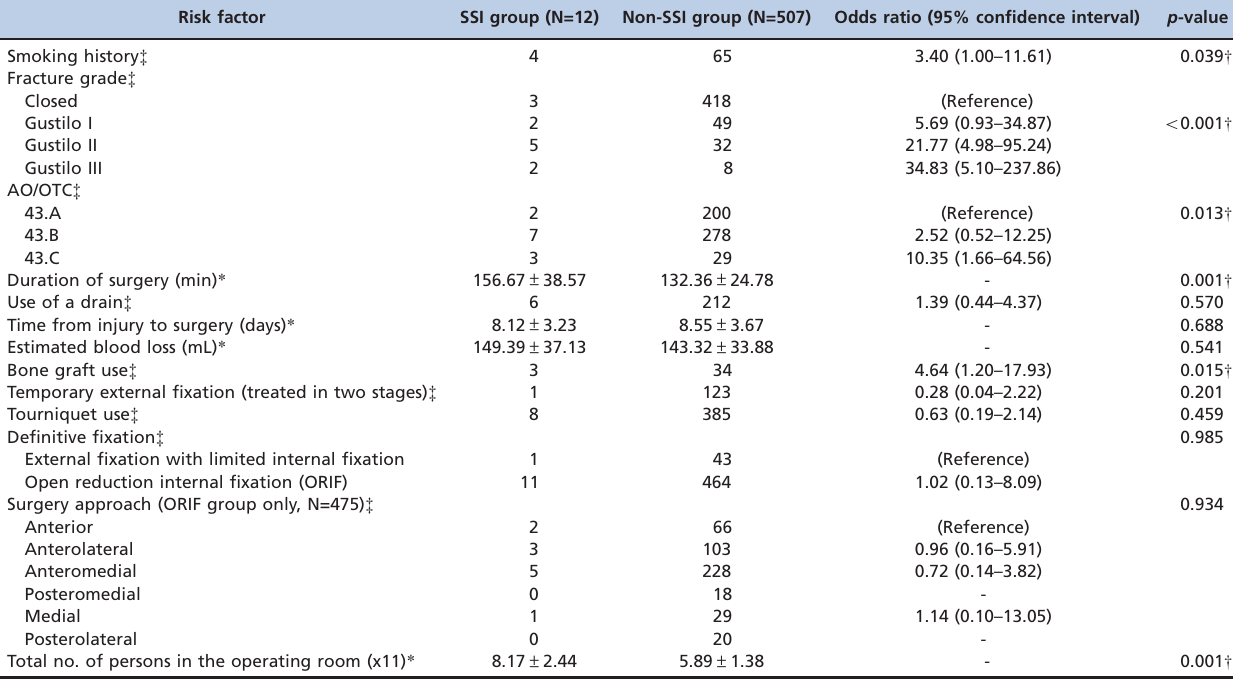
Table 1 - Distribution of a subset of clinical and therapy-related variables in patients with surgical site infection and in controls.